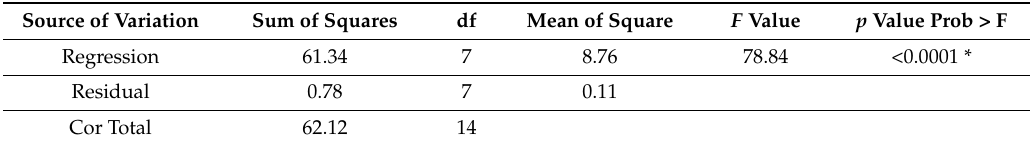
Table 5. Analysis of variance for surface response.